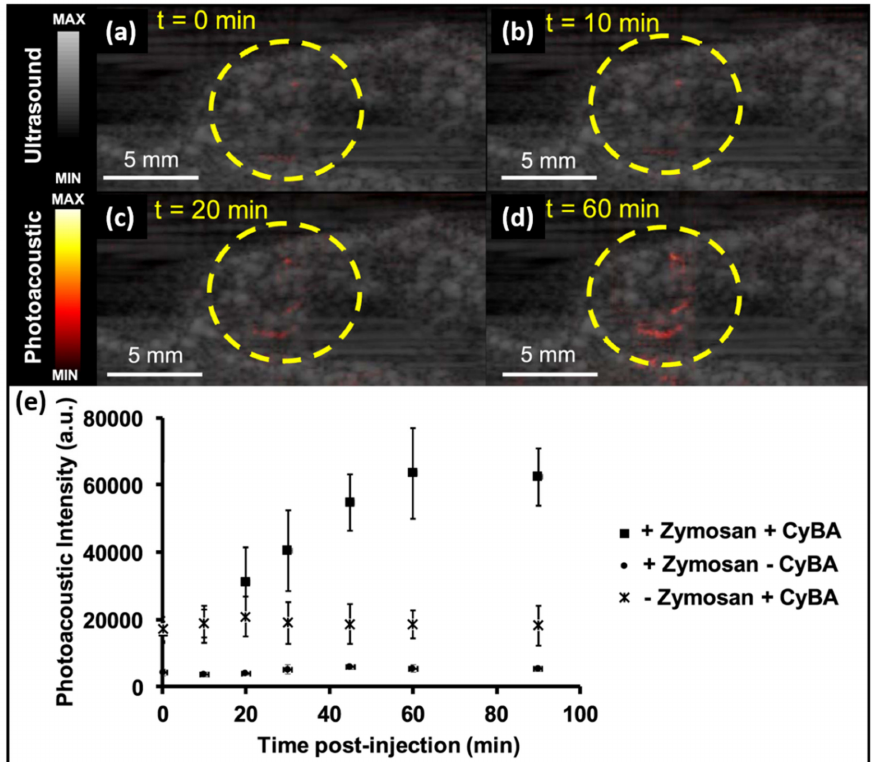
Figure 8. In-vivo PA evaluation of CyBA. US-PA image at ( a ) baseline, ( b ) 10, ( c ) 20, and ( d ) 60 min after CyBA injection. ( e ) Quantitative analysis of PA intensity as a function of time post-injection of CyBA. Reprinted from Ref.